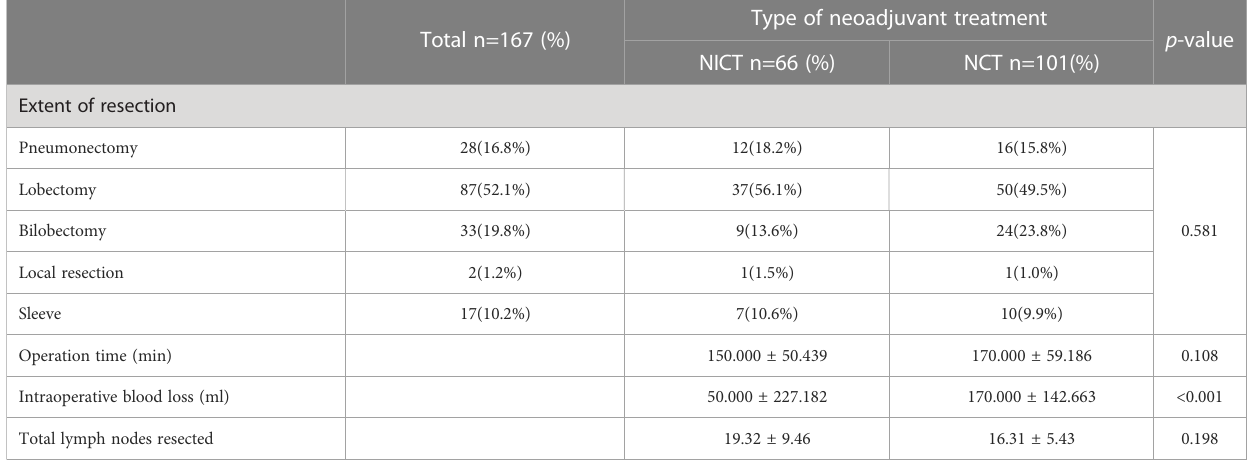
TABLE 3 Comparison of treatment modality and surgical outcomes for NSCLC patients.